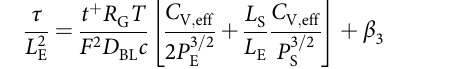
= Q ¼ 28 F = mAh . All errors in V ; eff V